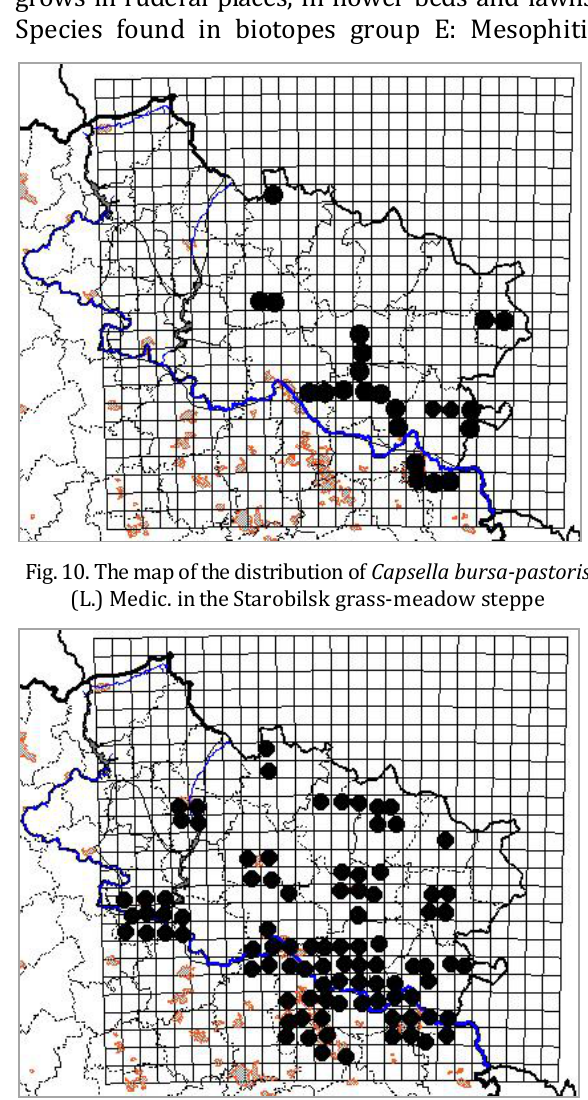
Fig. 13. The map of the distribution Cichorium intybus L. in the Starobilsk grass-meadow